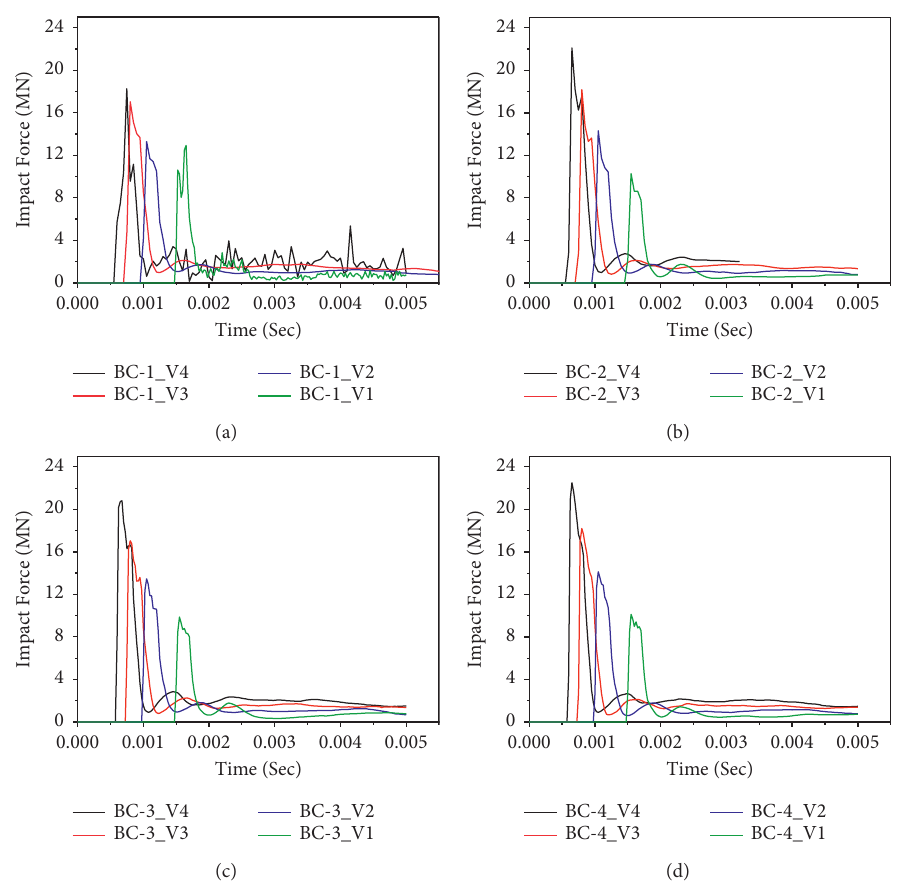
Figure 13: First impact force-time histories of unstrengthened BRC columns: (a) BC-1; (b) BC-2; (c) BC-3; (d)